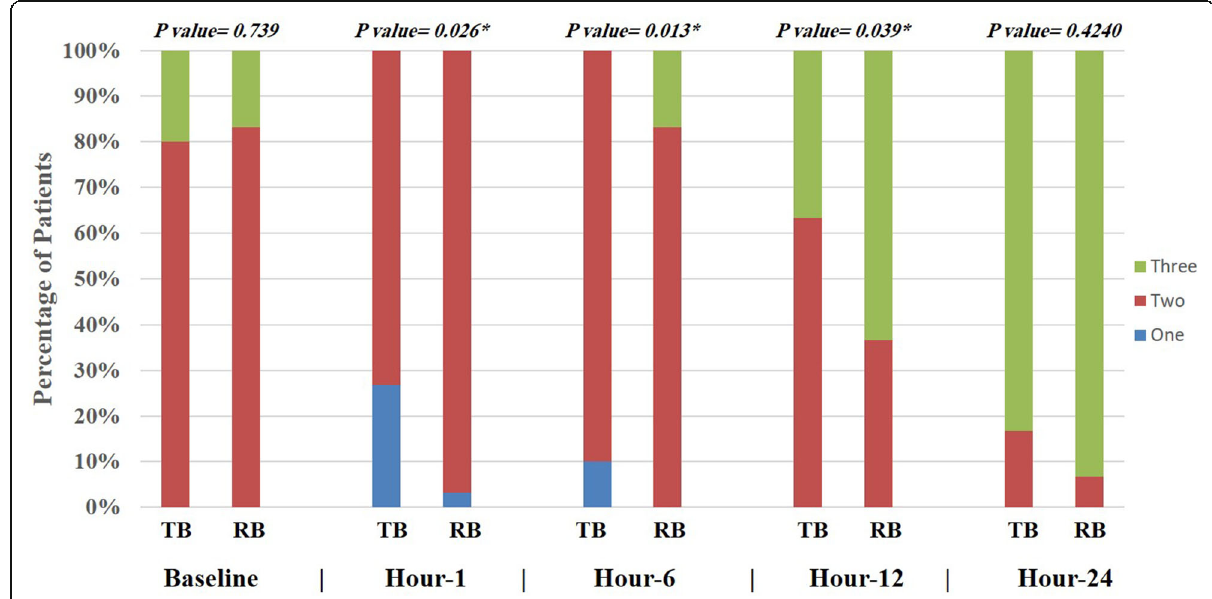
Fig. 2 Postoperative Respiratory functions as measured by the flow-oriented incentive spirometer among the study groups. * Significant. One, two, and three refers to the number of balls that patients were able to elevate by the incentive spirometer during inspiration which represents